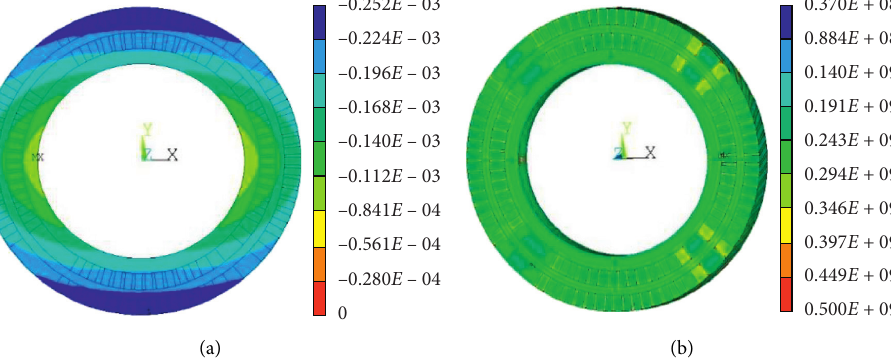
Figure 9: The radial displacement distribution (a) and equivalent stress distribution (b) of the structure during cooling